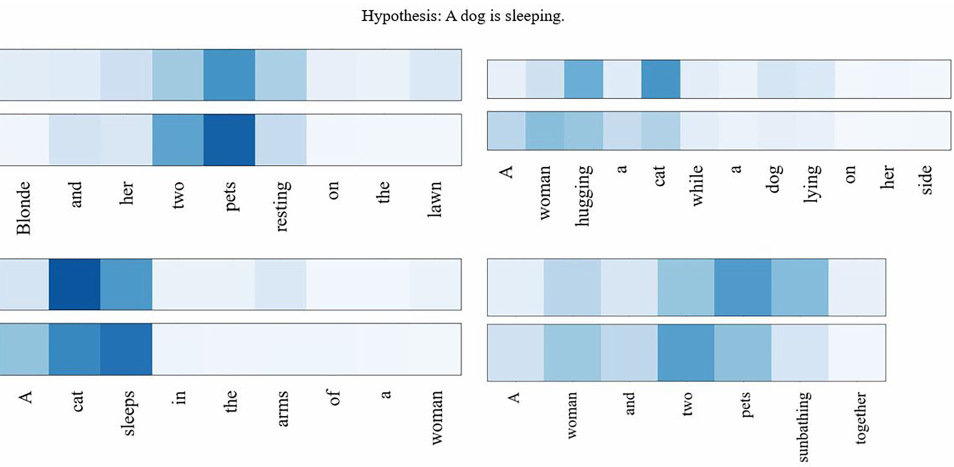
Figure 8. Attention visualizations for another